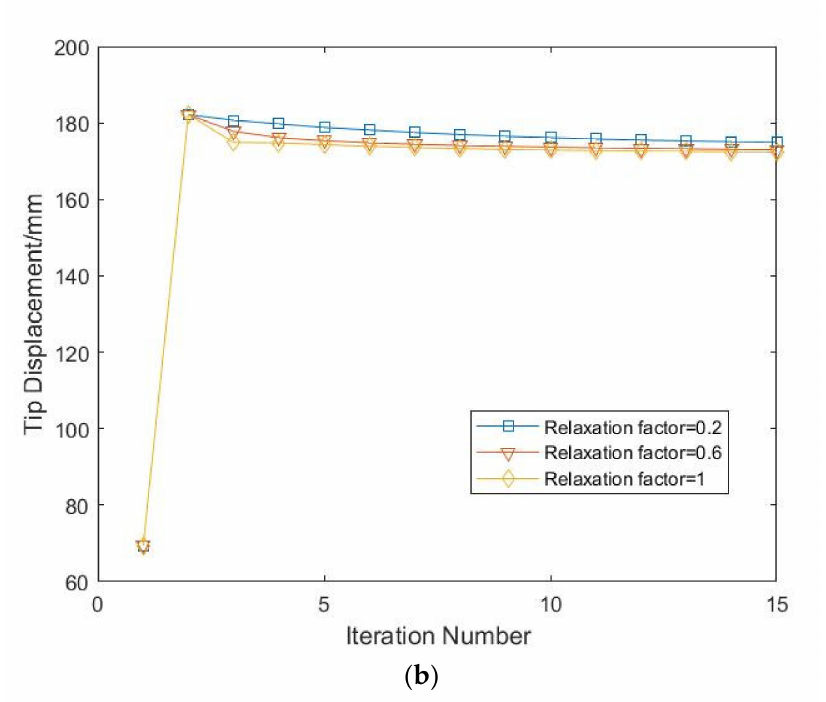
Figure 11. Application of fixed relaxation parameter to various system components: ( a ) relaxing factor with and without force or deflection; ( b ) the influence of relaxation factor on the convergence rate.